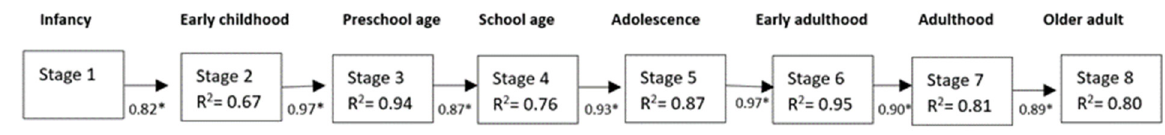
Table 1. The relationship of the eight stages of ego development ( n = 292).